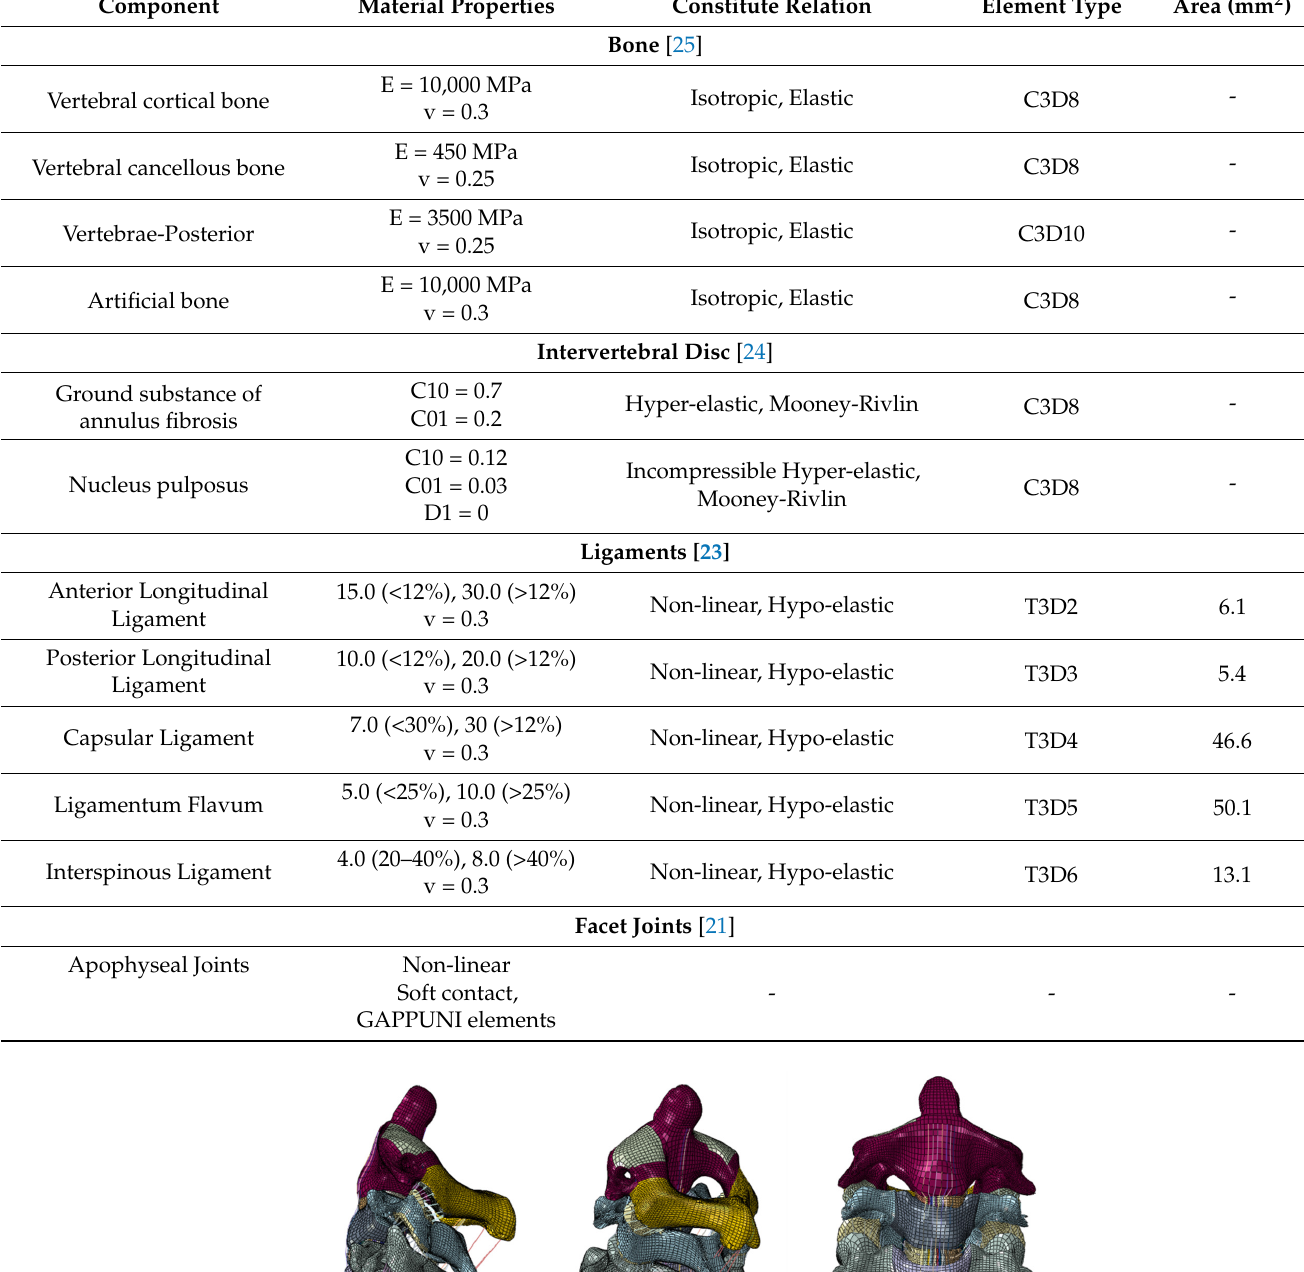
Table 1. Material properties assigned to the finite element model [21–25].